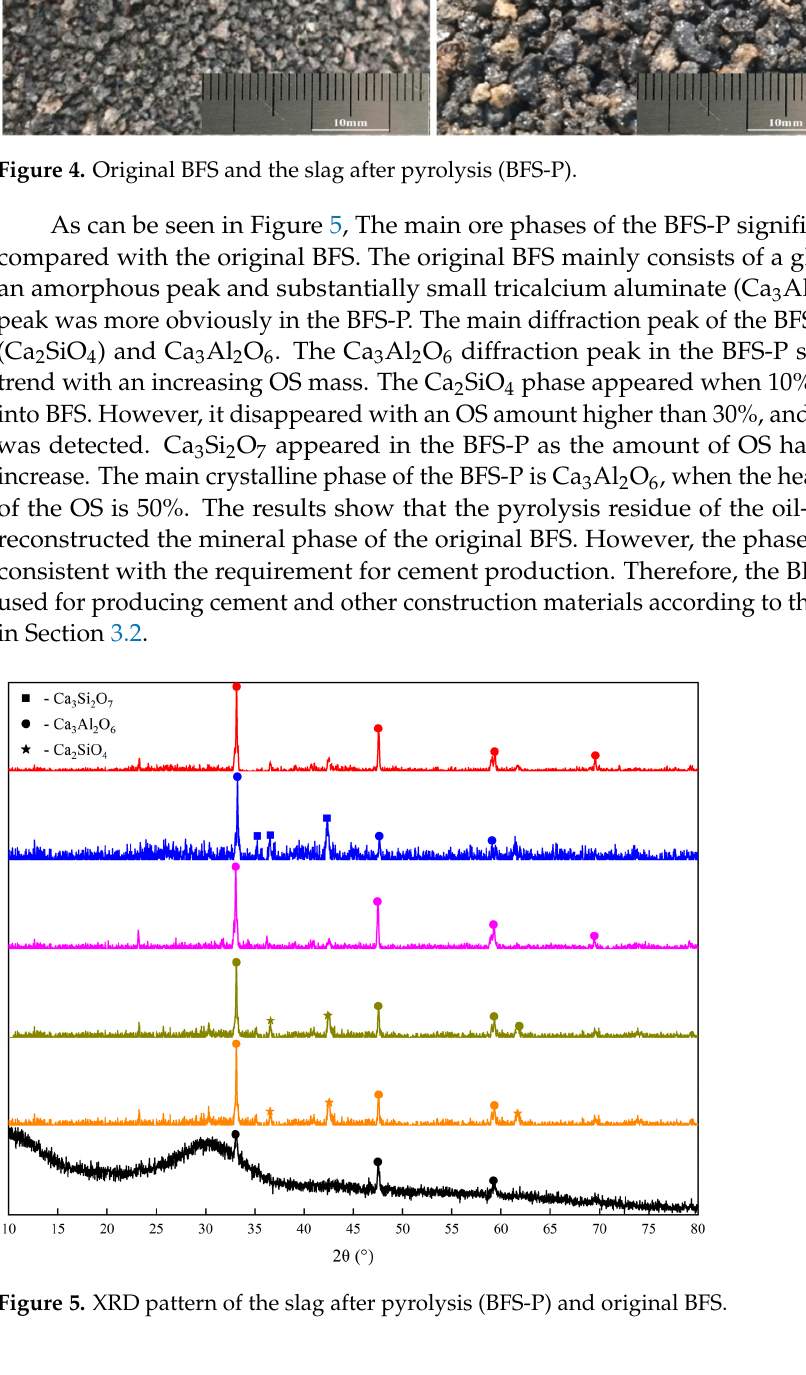
Figure 4. Original BFS and the slag after pyrolysis (BFS-P).